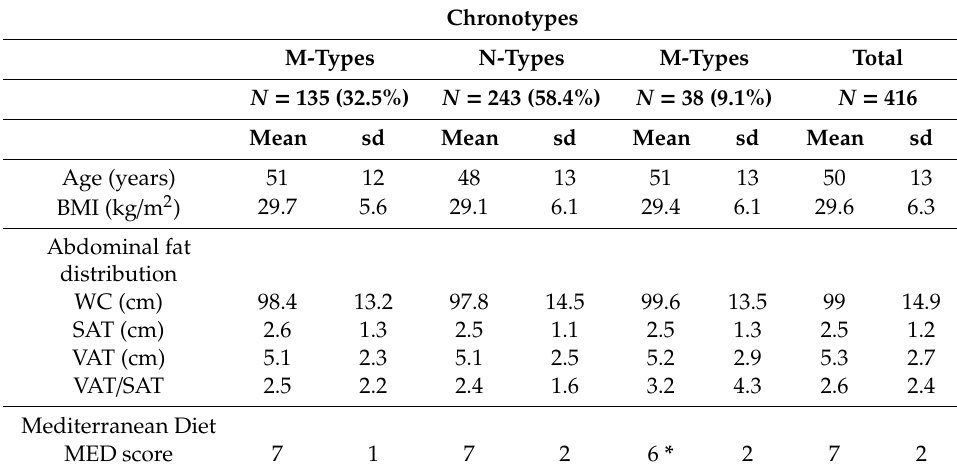
Table 1. General characteristics of the study subjects.